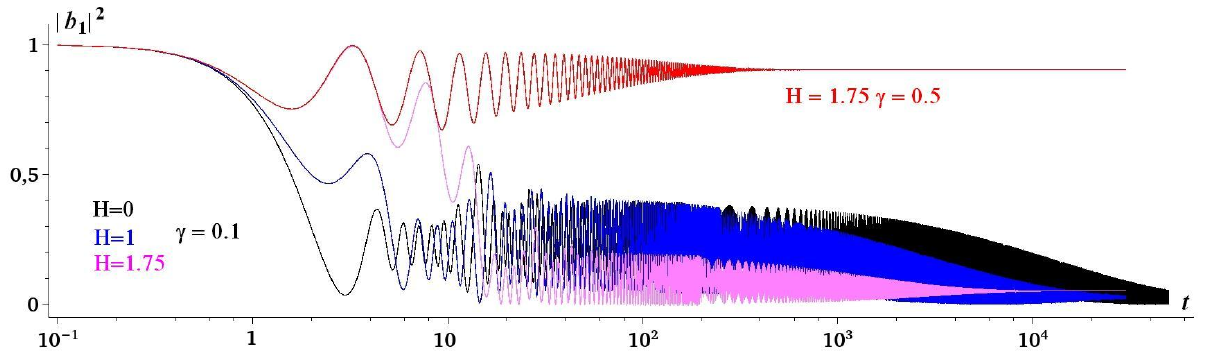
Figure 3. The probability of finding a charge on the first site as a function of time for di ff erent values of the electron energy H ≥ 0. Graphs are on a semi-logarithmic scale.